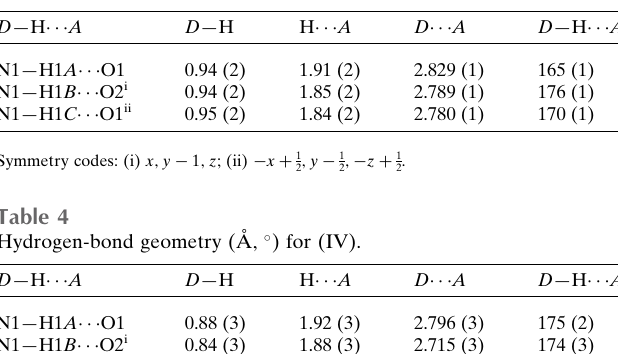
Table 3 Hydrogen-bond geometry (A˚ , (cid:5) ) for (III).